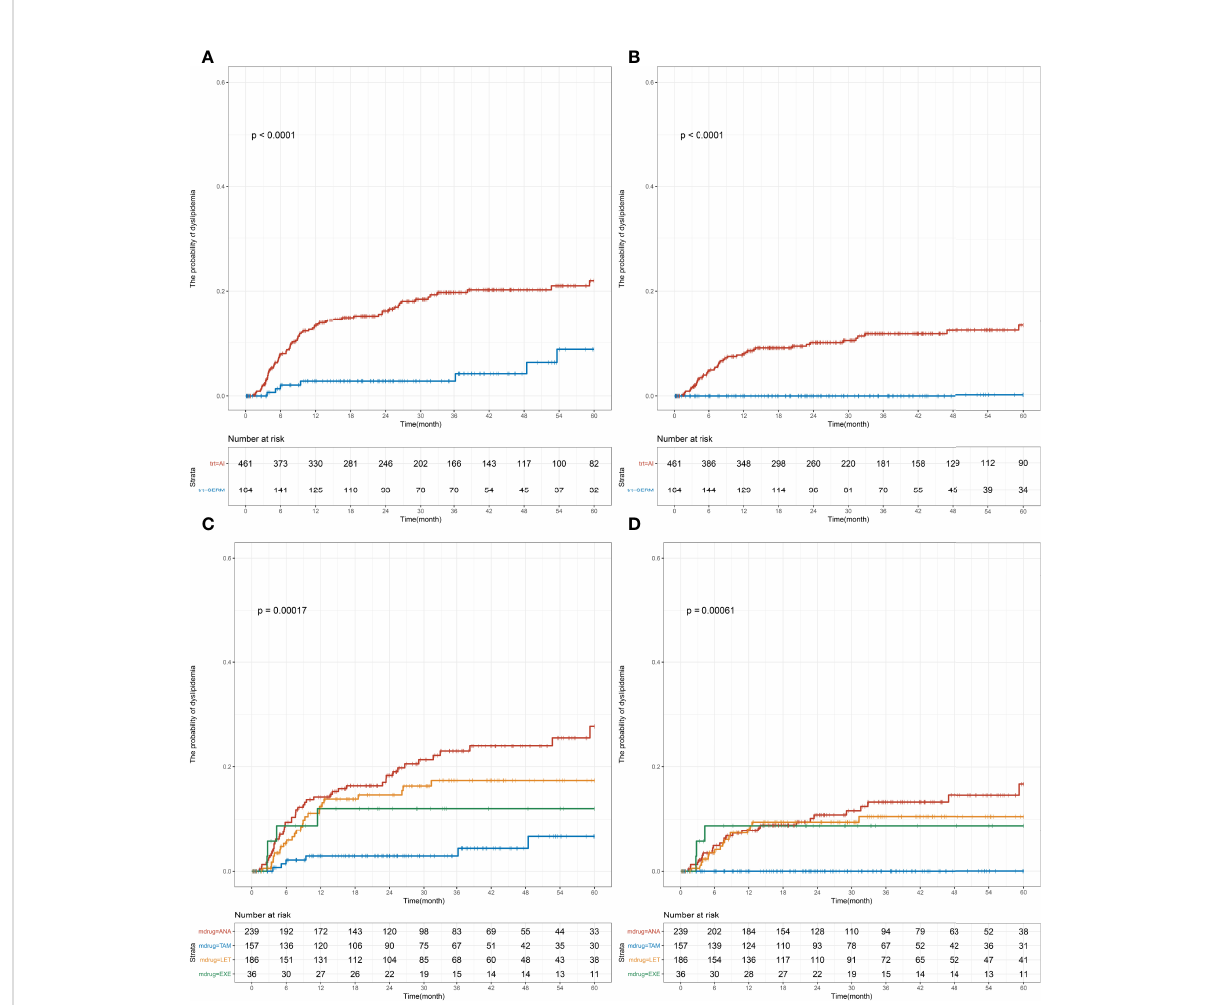
FIGURE 4 Cumulative abnormal TC and LDL-C incidence among early-stage breast cancer menopausal patients based on endocrine therapy used. Cumulative curves showing TC (A, C) and LDL-C (B, D) dyslipidemia incidences. p -values were obtained from the log-rank tests for comparisons of abnormal TC and LDL-C incidences between the different endocrine therapy groups. SERM, selective estrogen receptor modulator; TAM, tamoxifen; TOR, toremifene; AI, aromatase inhibitor; ANA, anastrozole; LET, letrozole; EXE, exemestane; TC, total cholesterol; TG, triglyceride; HDL-C, HDL cholesterol; LDL-C, LDL